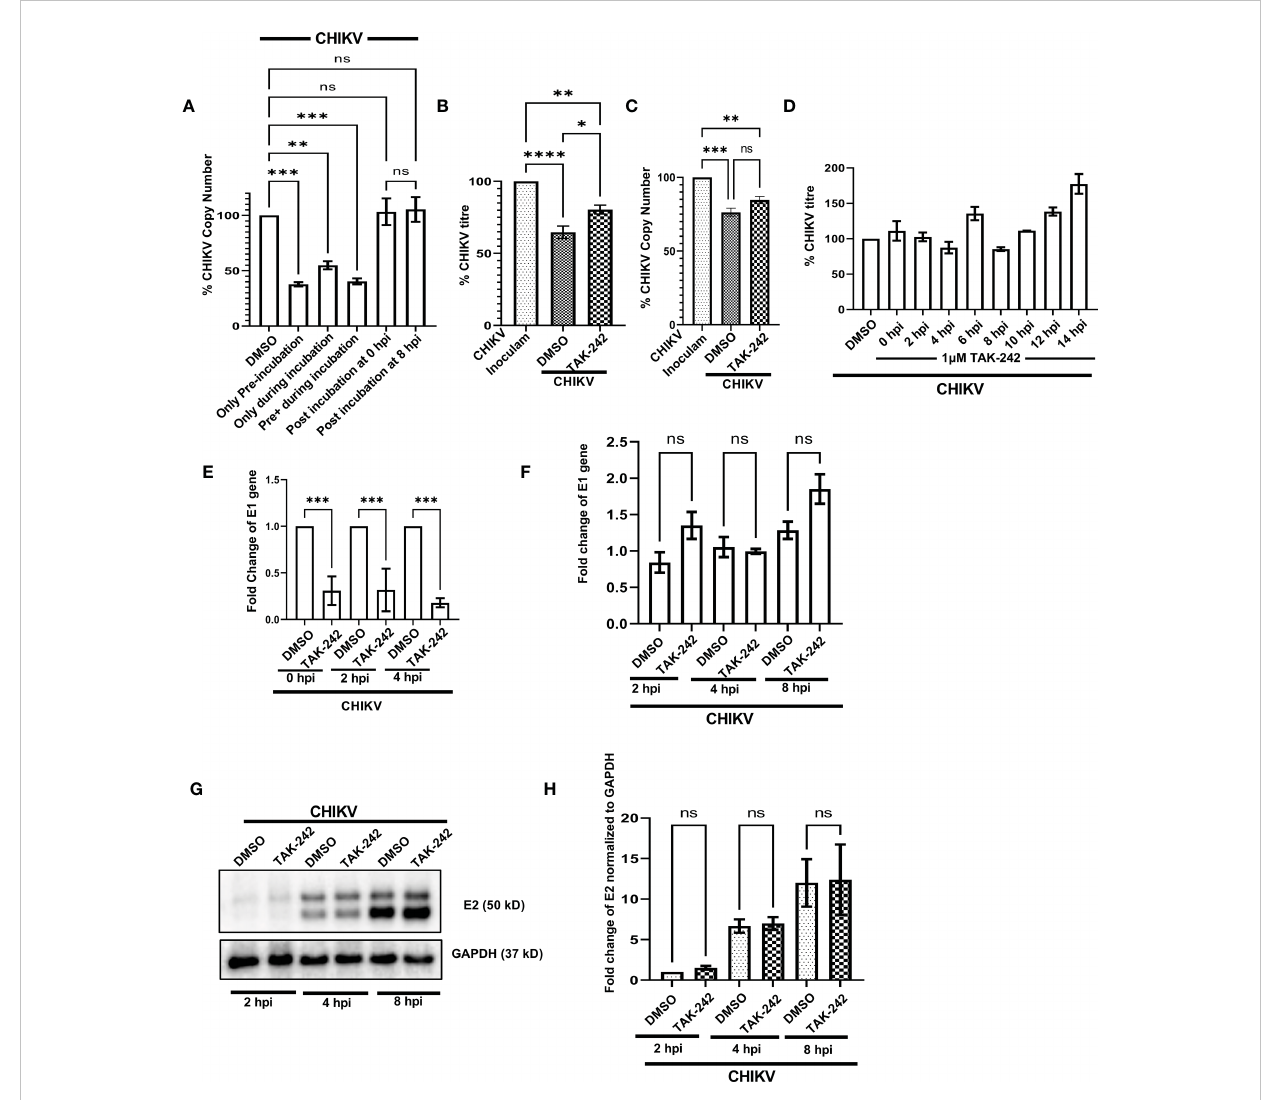
FIGURE 6 TLR4 promotes viral entry at the early stages of CHIKV infection in host macrophages, in vitro . (A) TLR4 inhibition before CHIKV infection is most effective to regulate viral copy number at 8 hpi (B, C) Viral entry assay in RAW 264.7 cells showing the internalization of around 24% and 11% less virus in TAK-242 treated condition using plaque assay-based viral titre determination and q-RT PCR based viral copy number determination respectively. (D) Time of addition assay in RAW 264.7 cells showed no signi fi cant decrease in viral infection during post-infection treatment. (E) TAK- 242 pre-treatment decreases CHIKV copy number in different time points inside the RAW264.7 macrophage cells. (F) Post-infection TLR4 inhibition (TAK-242 was added at 0 hpi) does not have a role in CHIKV E1 gene transcription in the RAW264.7 cells. (G, H) Post-infection TLR4 inhibition